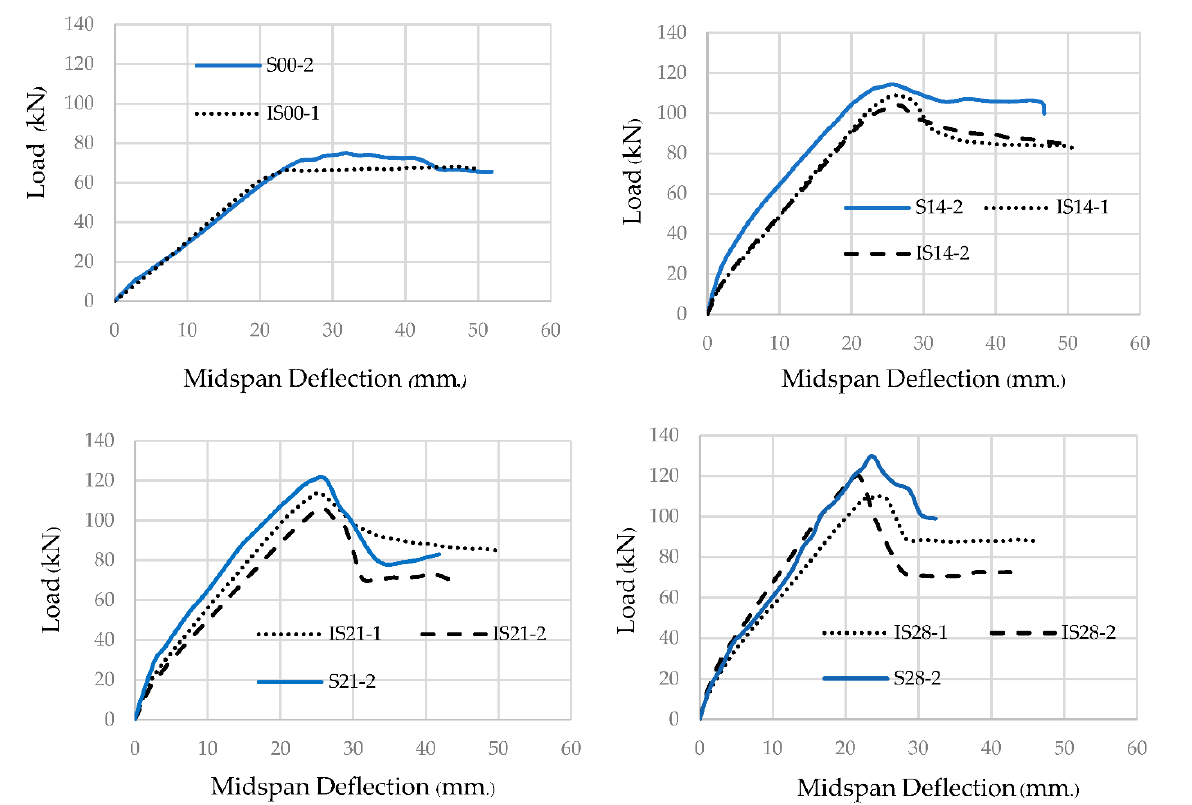
Figure 10. Load-midspan deflection curves from the static load tests (Series II).